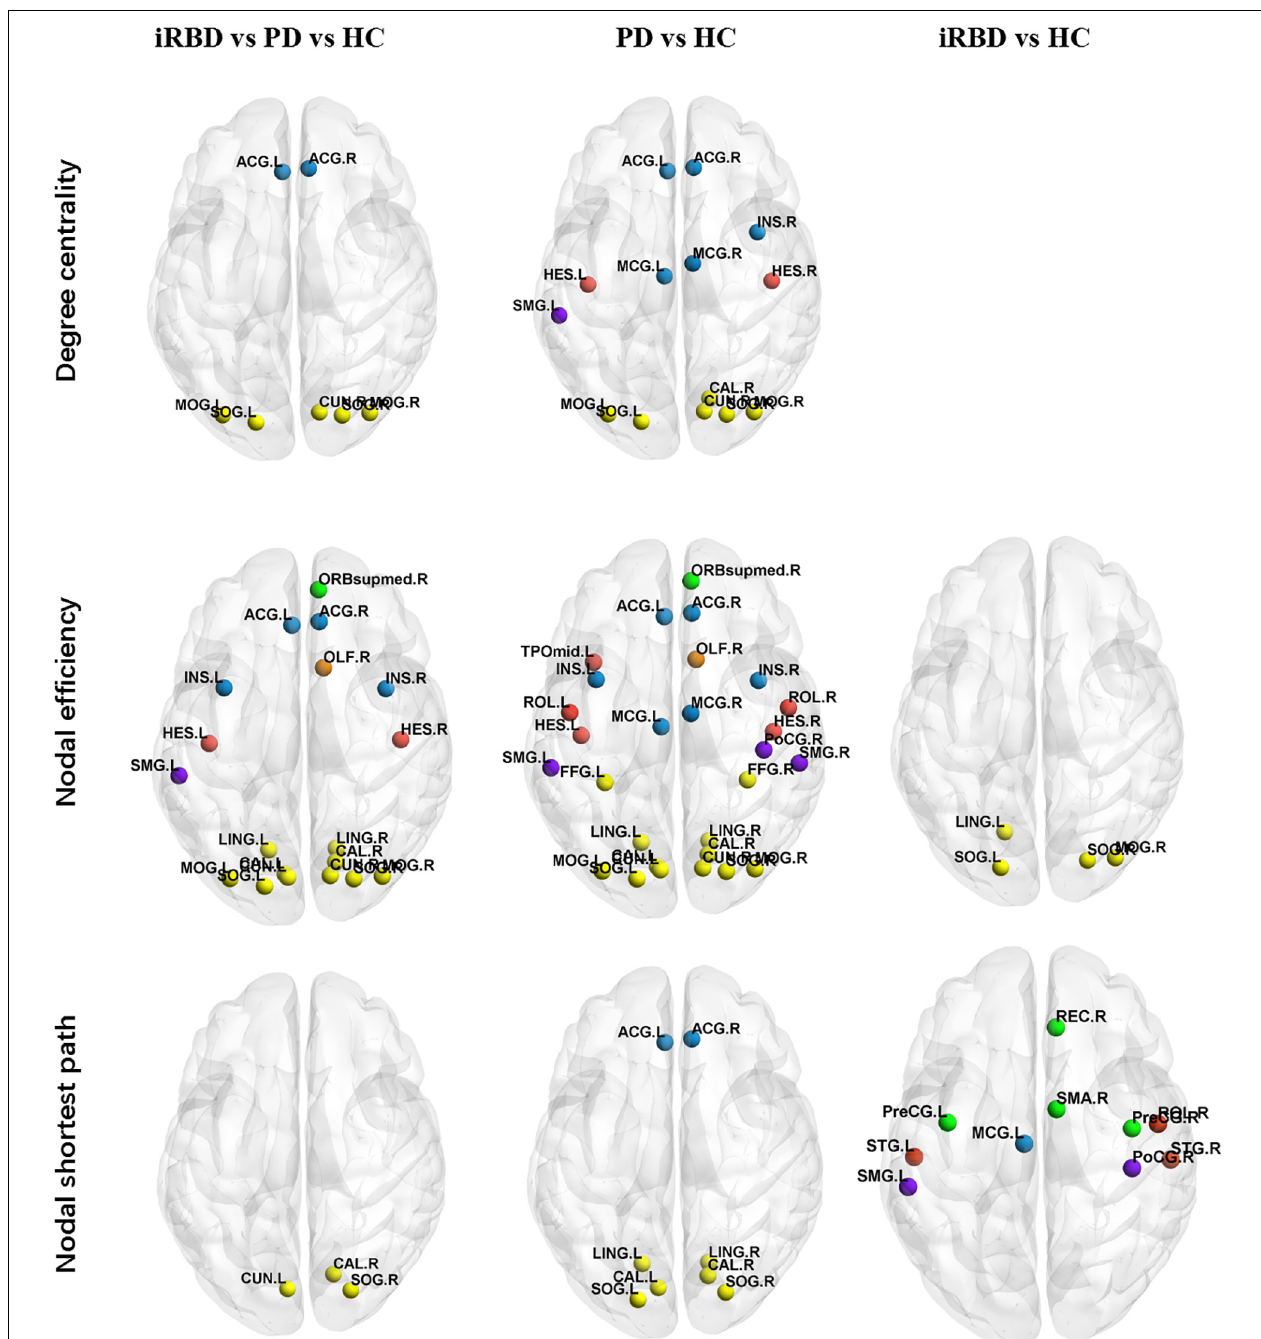
FIGURE 2 | Altered local topological properties in iRBD, PD, and HC. ( p < 0.01, p < 0.005, p < 0.005, respectively, all FDR corrected). Details are listed in Table 3 . Different brain regions were indicated by colors. Yellow: occipital lobe; red: temporal lobe; green: frontal lobe; purple: parietal lobe; blue: limbic lobe; orange: olfactory bulb. ORB mid, middle frontal orbital, orbital part; INS, insula; ACG, anterior cingulum gyrus; MCG, middle cingulum gyrus; LING, lingual; SOG, superior occipital gyrus; MOG, middle occipital gyrus; IOG, inferior occipital gyrus; PoCG, postcentral gyrus; SMG, supramarginal gyrus; REC, rectus gyrus; ROL, rolandic